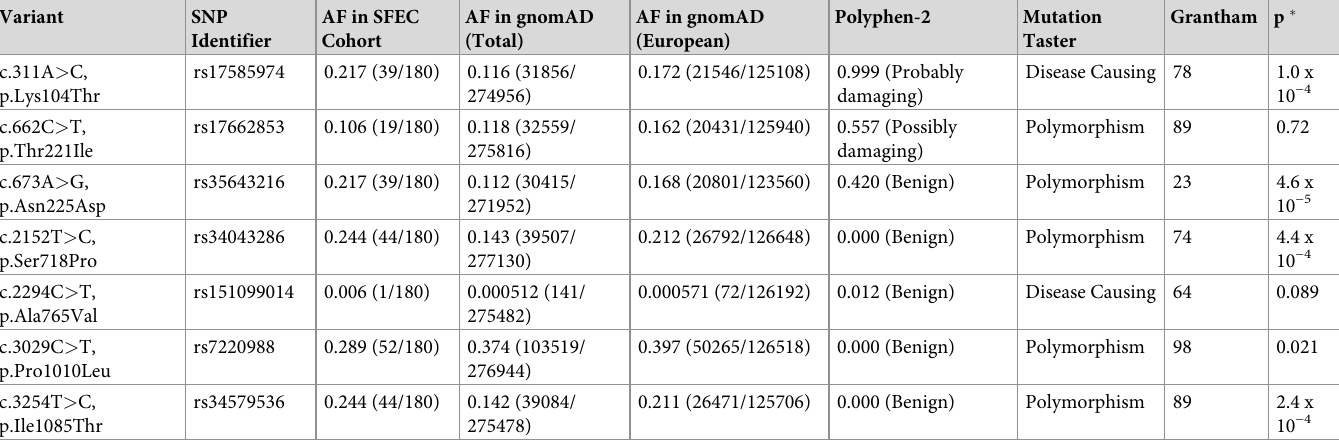
Table 1. Missense variants identified in screen of 90 patients with SFEC